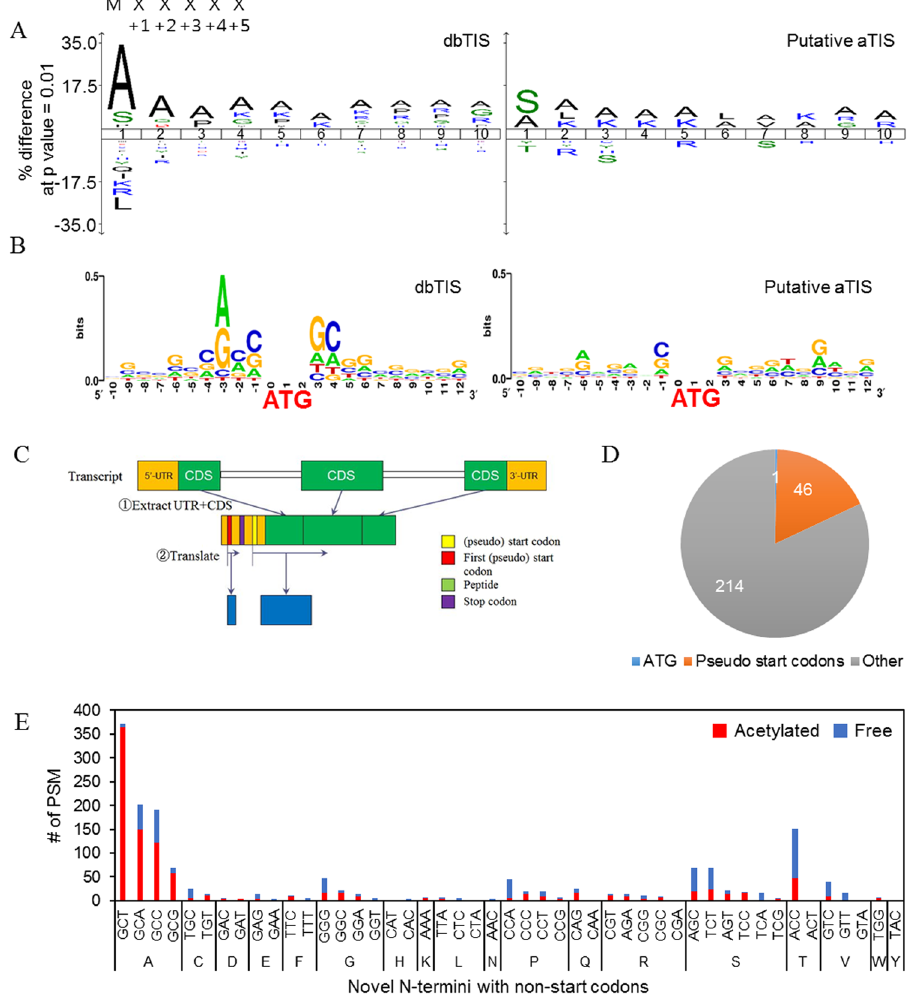
Figure 5. Putative alternative translational initiation sites. ( A ) iceLogo diagrams for amino-acid occurrences between dbTIS and putative aTIS. The amino acid frequencies after any methionine (either iMet or internal Met) in the human Swiss-Prot database (release 2015. 1) were determined for use as background correction. The sequences start immediately after methionine. ( B ) Nucleotide sequences at the flanking region of the initiator methionine residue. The central ATG is the codon for the initiator methionine of dbTIS (left) and putative aTIS (right). ( C ) The design of NtermDB. It is designed to allow a search for novel protein N-termini within an upstream UTR region. Orange blocks represent UTR regions, and green blocks represent coding sequence regions (CDS). Novel protein N-terminus was assumed to start at the start codon (“ATG”) or a pseudo start codon along the same frame as that of the matching CDS. We chose the farthest upstream (pseudo) start site and in-silico translated the transcript model. See methods for more details. ( D ) Codon usage in the identified novel N-termini. Nucleotide sequences corresponding to the first residue of the identified 5 ′ -UTR peptides are presented. ( E ) Number of PSMs for acetylated or free N-terminal 5 ′ -UTR peptides starting with non-start